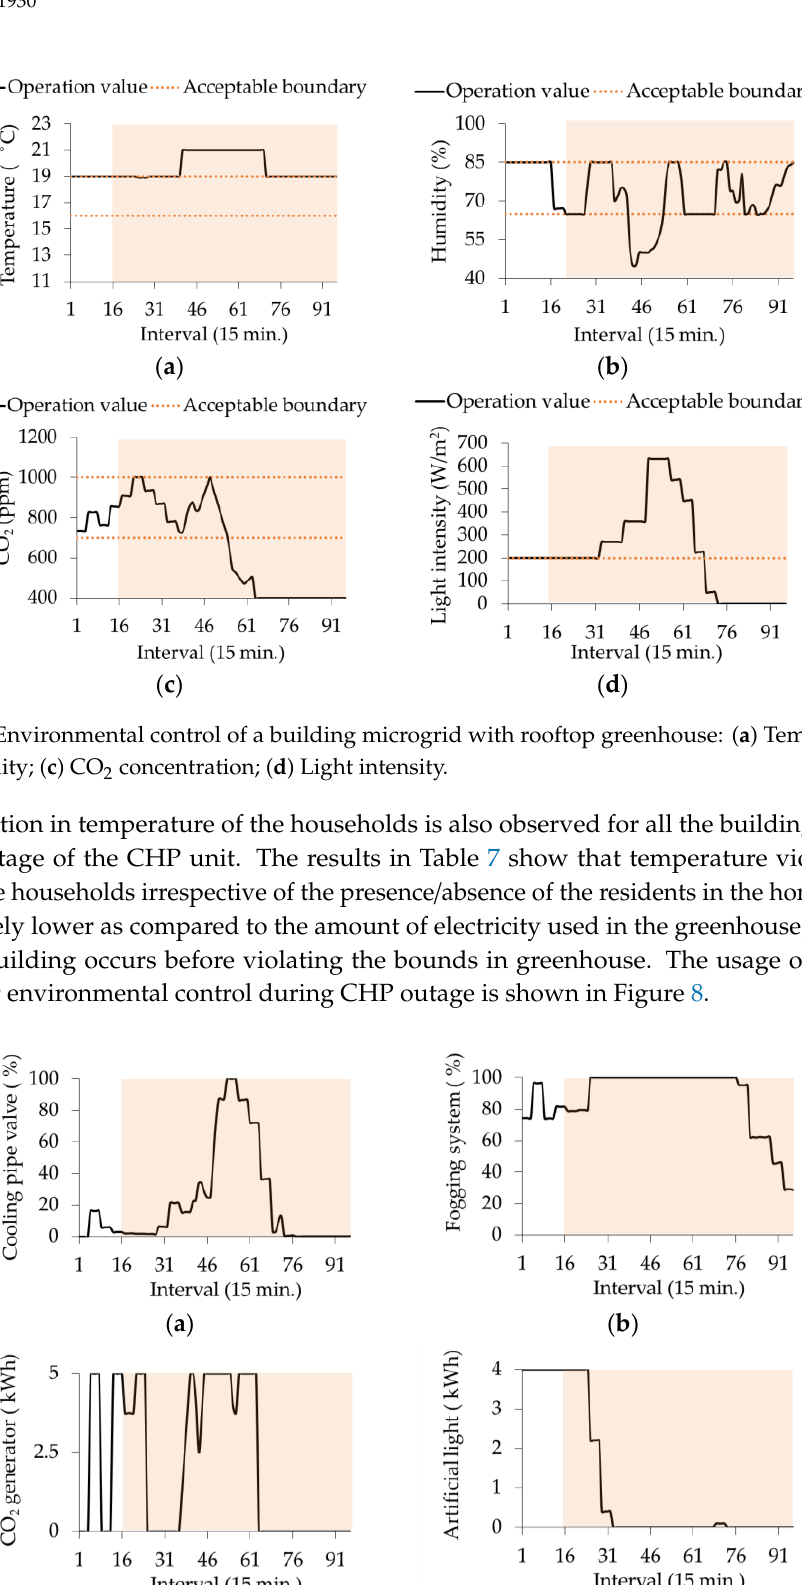
Figure 8. Equipment usage for environment control in a building microgrid with rooftop greenhouse: ( a ) Cooling pipe valve; ( b ) Fogging system; ( c ) CO 2 generator; ( d ) Artificial light. Table 7. Temperature control of each household in the building.